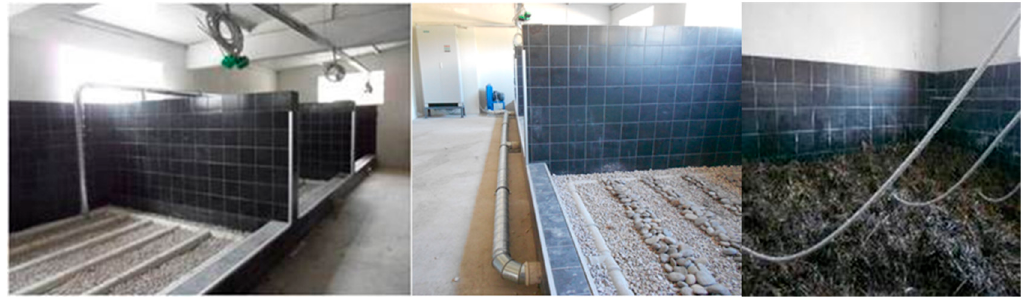
Figure 1. Aerated static pile composting system.